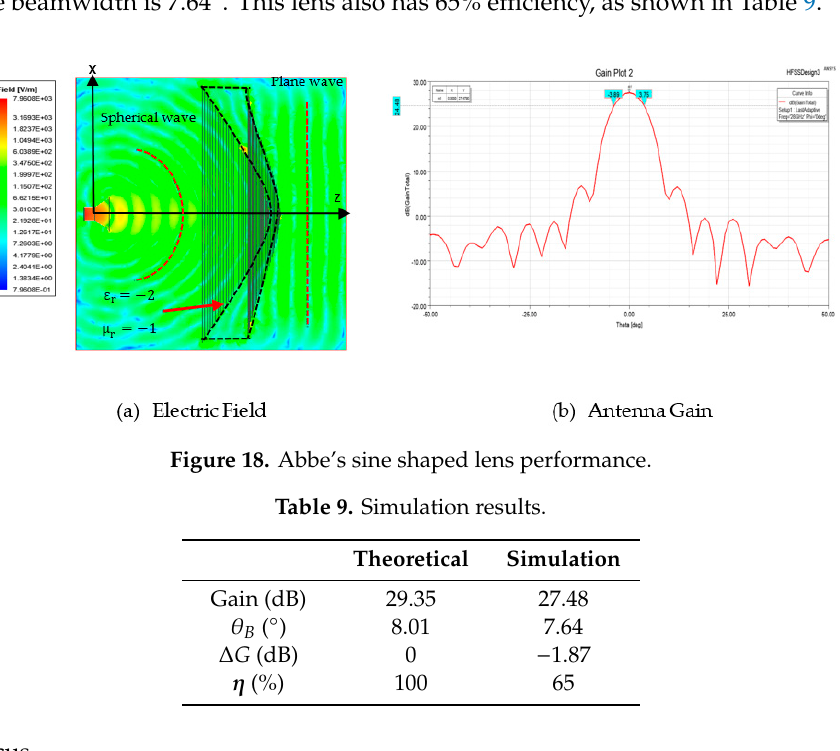
Figure 17. Electric phase distribution.